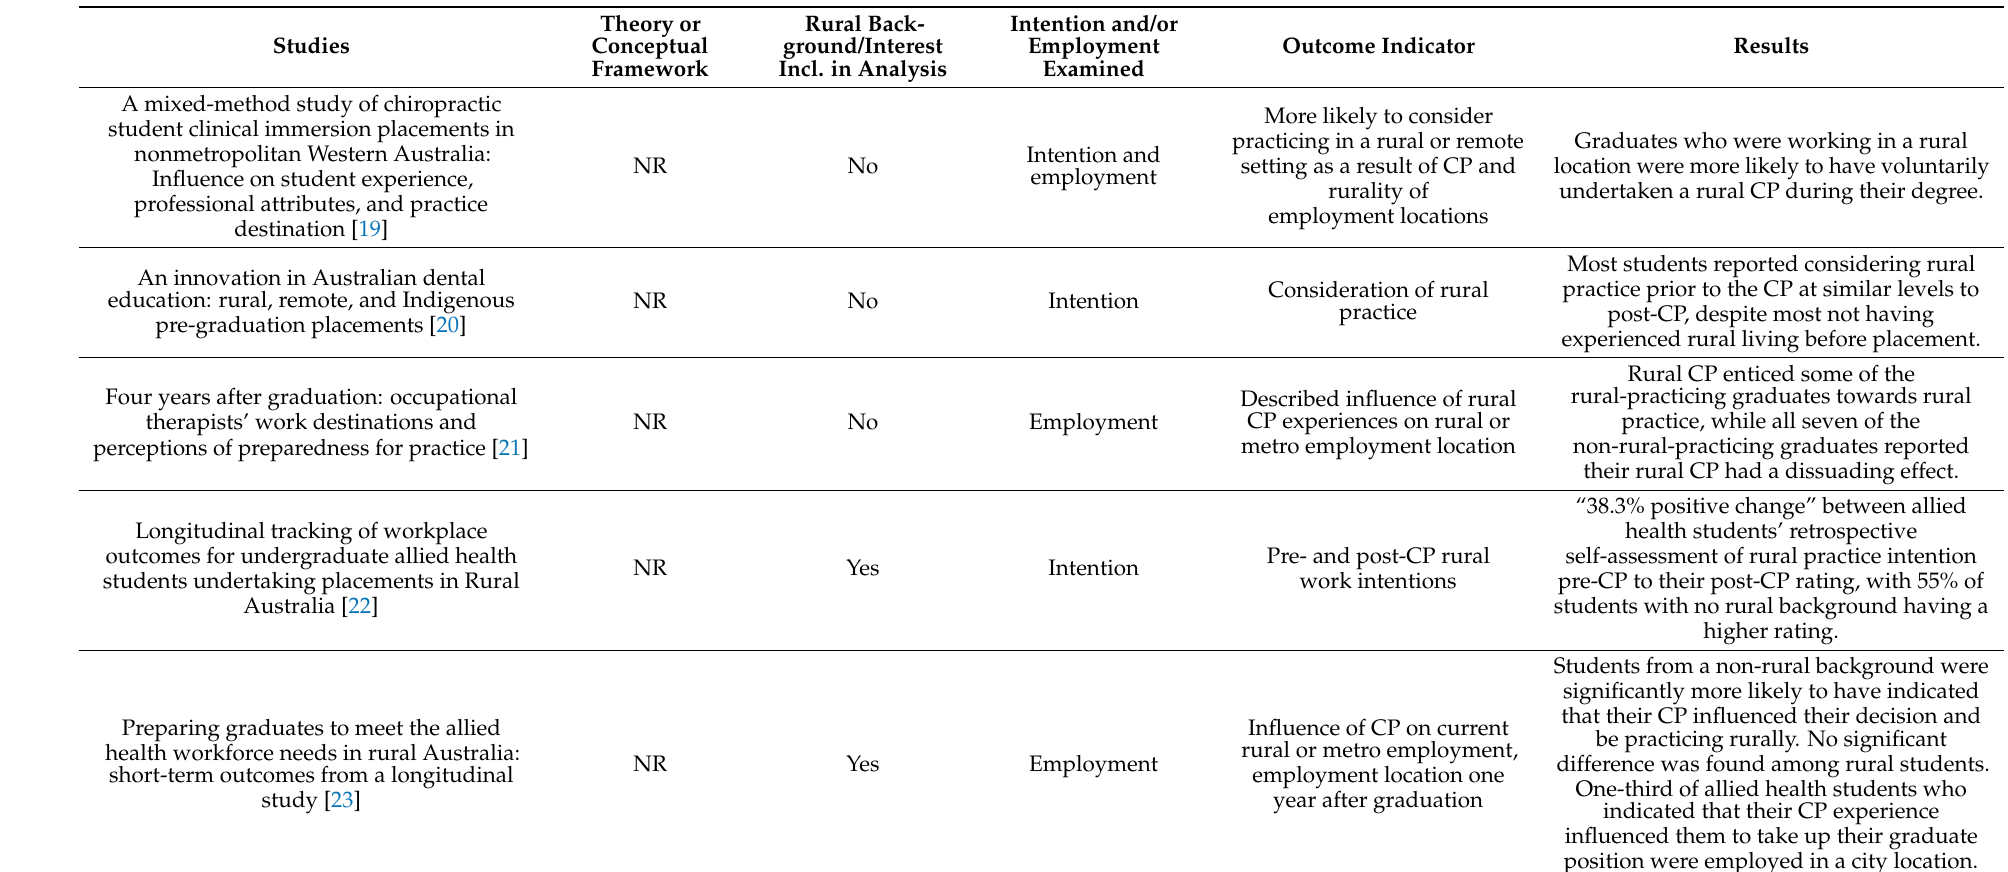
Table 4. Review findings presented by outcome (intention and/or employment)